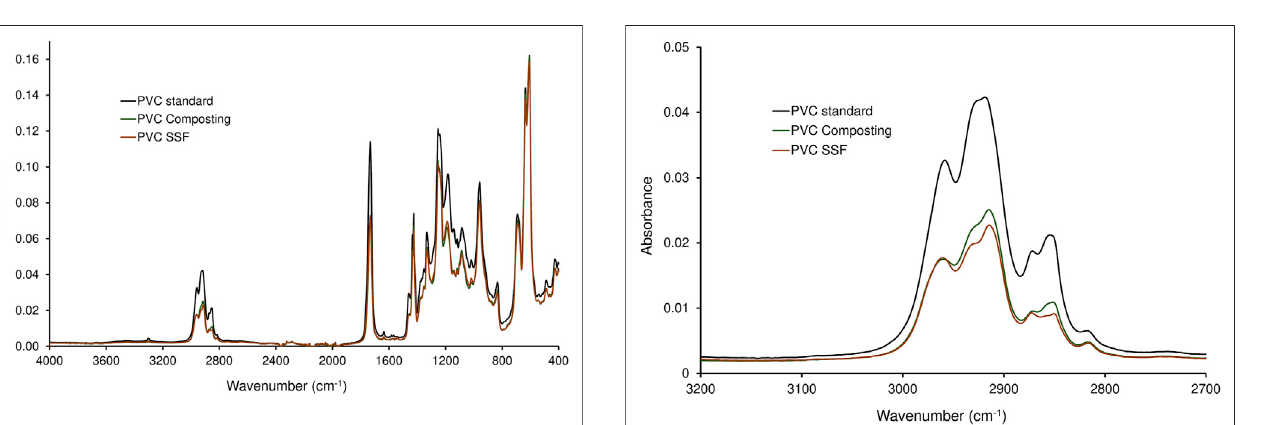
FIGURE 3 | Spectra of PVC treated in a two-stage degradation procedure by composting ( fi rst stage, 42 days; PVC Composting) and by B. amyloliquefaciens (second stage, 68 days; PVC SSF) compared to virgin PVC standard.